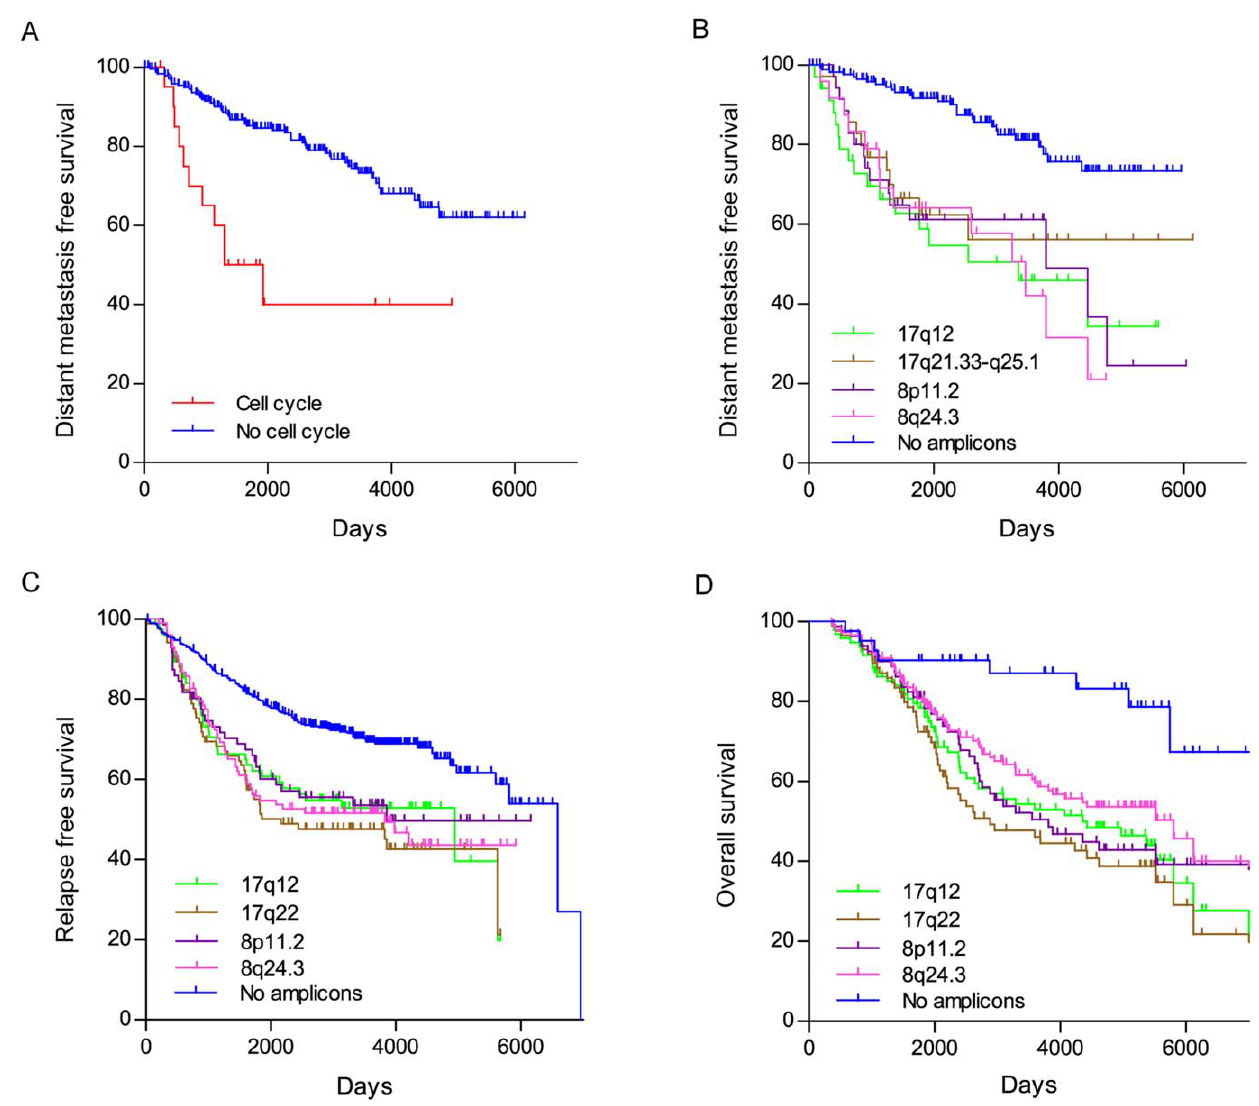
Figure 2. Patients with cell cycle pathway activation or outliers patterns consistent with amplification of 17q12, 17q21.33-q25.1, 8p11.2 and 8q24.3 show poor outcome under tamoxifen treatment. A) Kaplan-Meier curves of the samples in the primary dataset (GSE6532) enriched for over-expressed cell cycle genes versus the rest of samples that don’t show this feature. Patients with cell cycle activated genes show a significant decrease in distant metastasis free survival rate (HR =9.71, 95% CI =3.3–28.6; P , 0.0001). B) Kaplan-Meier curves of the ER + samples in the primary dataset (GSE6532) stratified by presence of putative amplicons in 17q12, 17q21.33-q25.1, 8p11.2 and 8q24.3. Patients that show any one of the chromosomal amplifications have significantly higher relapse rates when compared to samples without any amplifications: 17q12 (HR =4.09, 95% CI =3.84–21.99; P =6.3e 2 07), 17q21.33– q25.1 (HR =3.14, 95% CI =2.17–13.62; P =3.0e 2 04), 8p11.2 (HR =3.75, 95% CI =3.18–18.31; P =5.7e 2 06), and 8q24.3 (HR =4.29, 95% CI =4.32–34.08; P =2.2e 2 06). C) Analysis of combined gene expression data of 624 ER + breast cancers from multiple published data sets. Outlier analysis was performed to identify cases with evidence of amplification at 17q12, 17q22, 8p11.2, and 8q24.3 and those without evidence of any amplification. Kaplan-Meier curves of relapse free survival for ER + samples with each of the four amplicons, and samples containing no amplicon are plotted: 17q12 (HR =2.30, 95% CI =1.45–3.64; P =4.0e 2 04), 17q22 (HR =3.07, 95% CI =1.99–4.73; P , 1.0e 2 04), 8p11.2 (HR =1.96, 95% CI =1.23–3.13; P =4.9e 2 3), 8q24.3 (HR =2.38, 95% CI =1.60–3.55; P , 1.0e 2 04) D) Kaplan-Meier curves of overall survival for the ER + samples in the test CGH dataset (GSE22133) with each of the 4 amplicons, as well as samples that don’t have any of the chromosomal amplifications. Analysis of the CGH data identified amplification peaks at each of the four regions that overlap with the previously identified loci. Patients that show any one of the chromosomal amplifications have significantly higher event rates than those without any of the amplifications: 17q12 (HR =2.61, 95% CI =1.51–5.51; P =6.8e 2 04), 17q22 (HR =3.02, 95% CI =1.76–5.18; P =7.3e 2 05), 8p11.2 (HR =2.65, 95% CI =1.48–4.74; P =1.3e 2 03), and 8q24.3 (HR =2.12, 95% CI =1.24–3.65; P =6.7e 2 03). Log-rank tests were used to calculate all the P values.